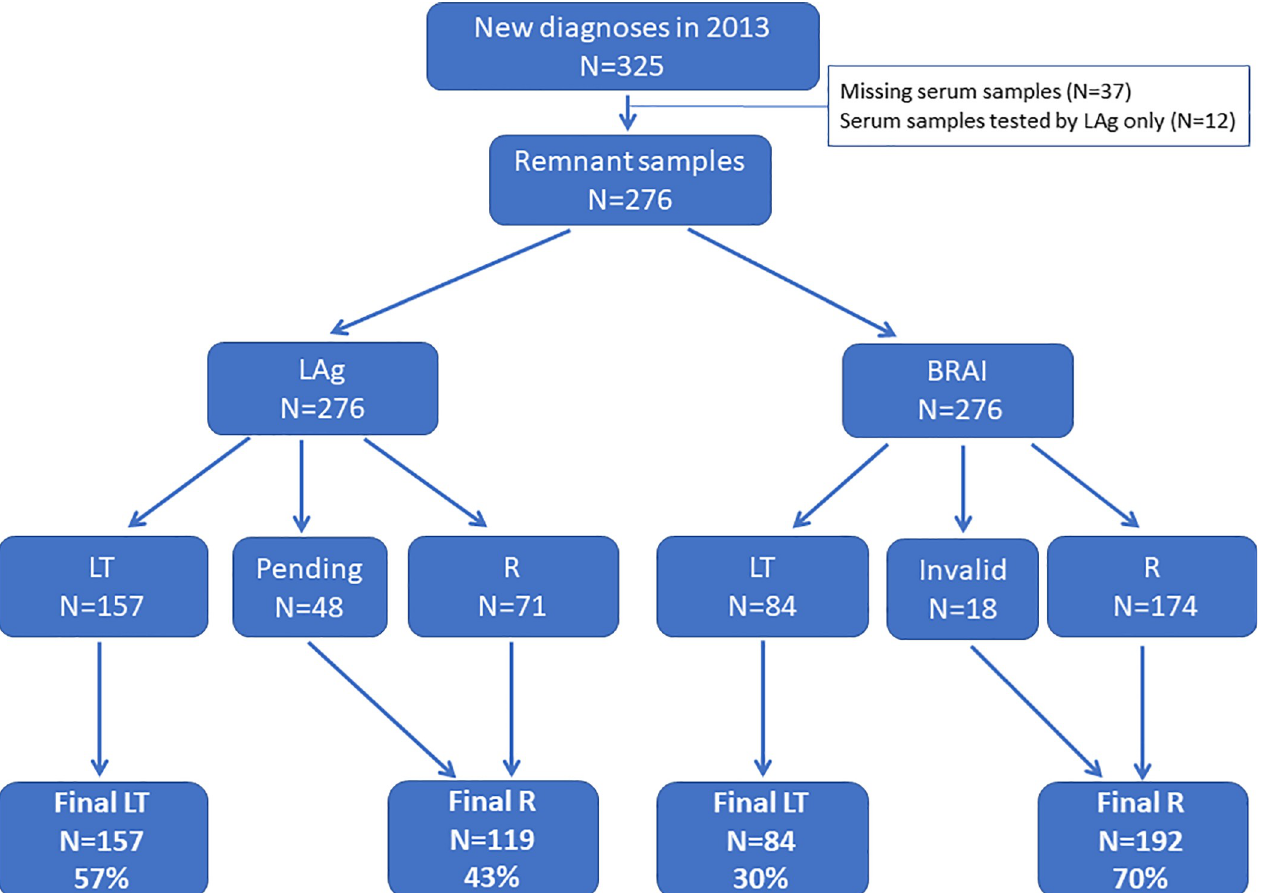
Fig 2. Determination of recent (R) and long-term (LT) HIV-1 infections by LAg and BRAI without inclusion of clinical data in the analysis.